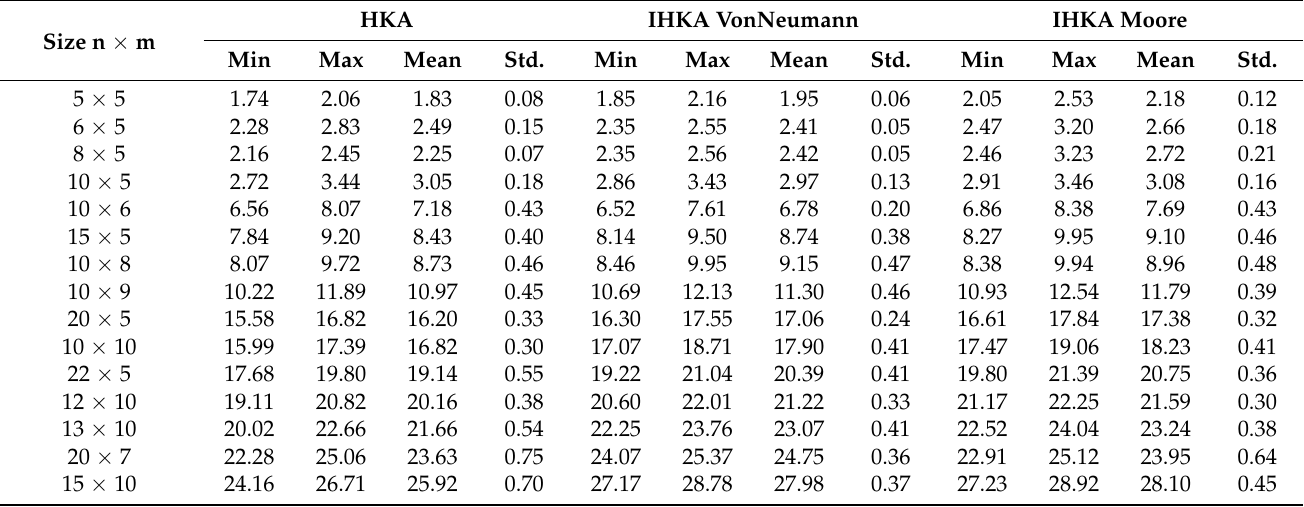
Table 6. The computational statistics of the IHKA and HKA on the running time for the benchmark instances of DJSSP.